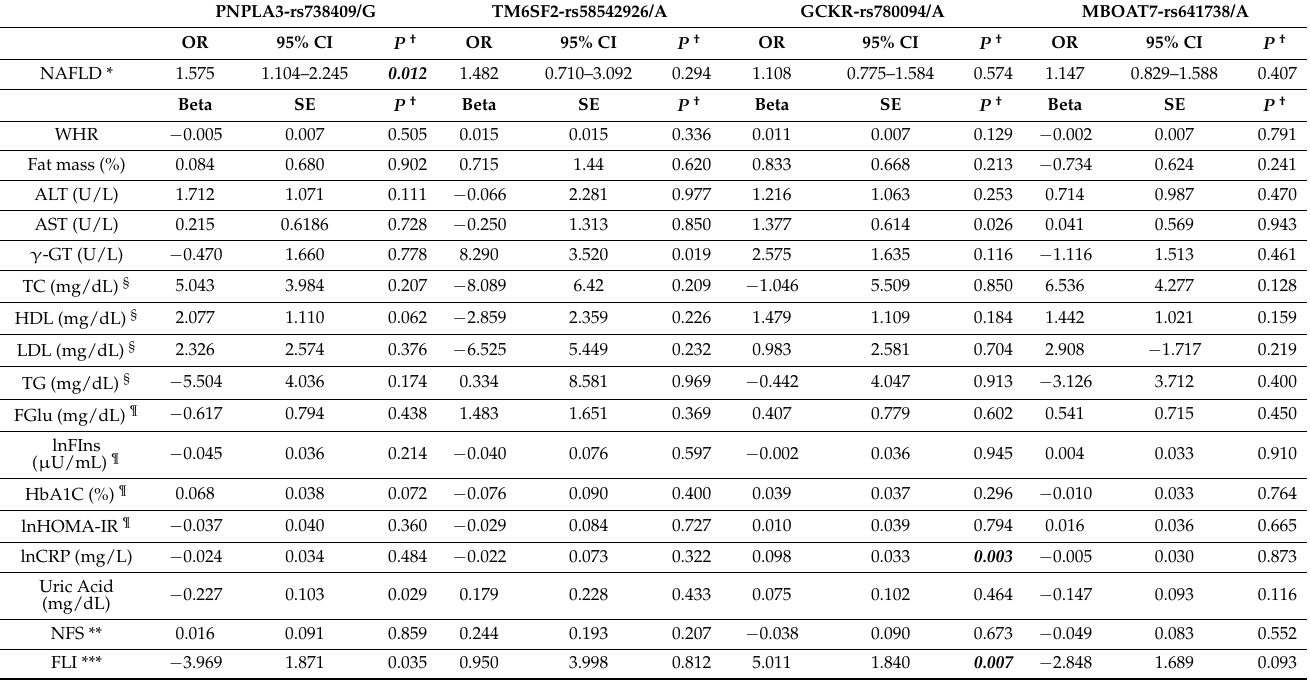
Table 2. Genetic associations with NAFLD and disease-related traits.